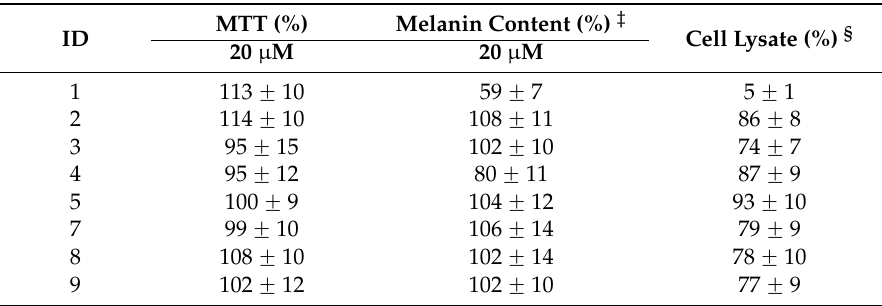
Effects of tyrosinase inhibitors on cell survival, melanin content, and cell lysates of mammalian B16F10 cells †